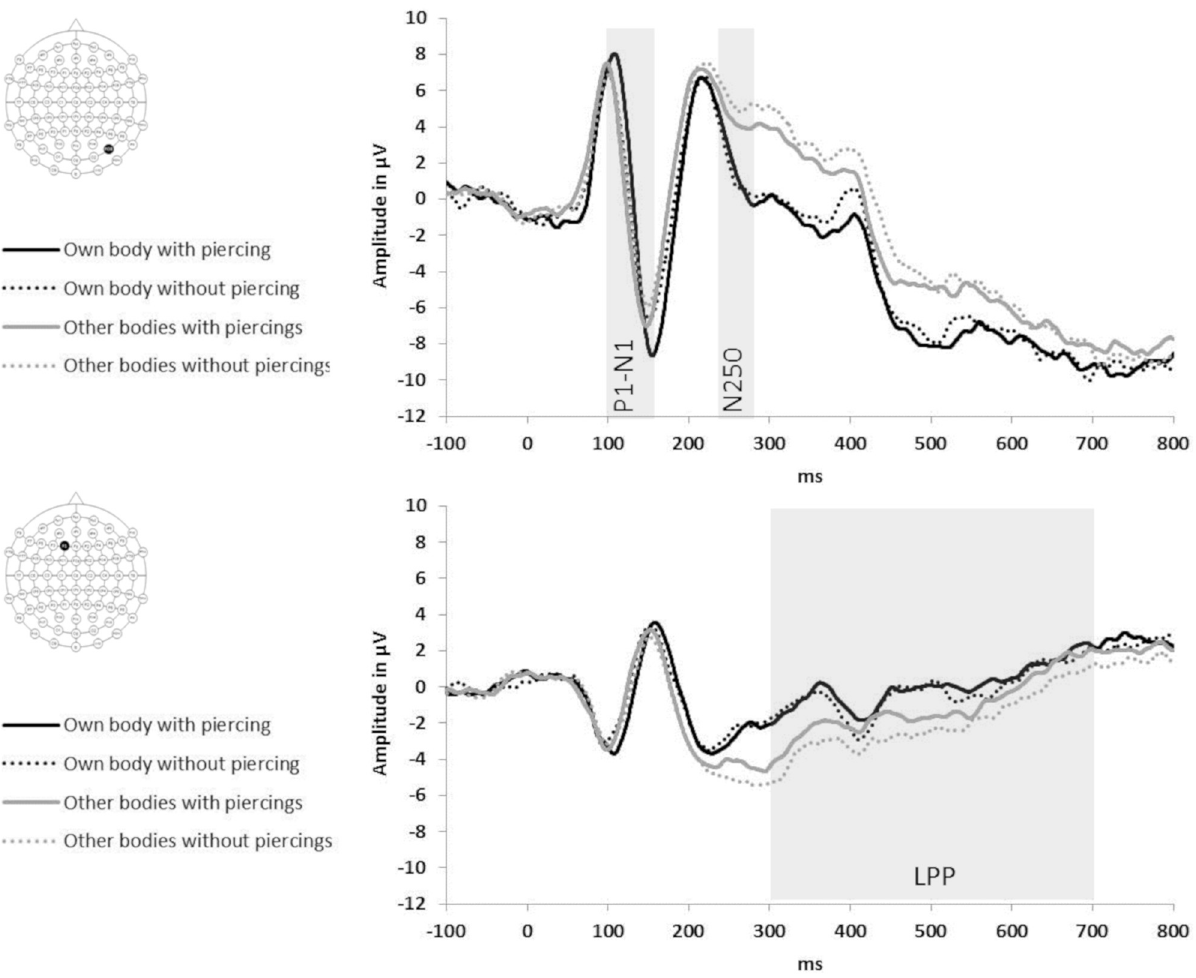
Fig 5. Visual ERPs, obtained during the self-recognition task, to images of participants’ own abdomen (black waveforms) and other women’s abdomens (grey waveforms) depicted with (solid waveforms) and without (dotted waveforms) navel piercings. Top panel shows right-hemispheric posterior electrode PO8; bottom panel shows left frontal electrode F1 (see insets for electrode